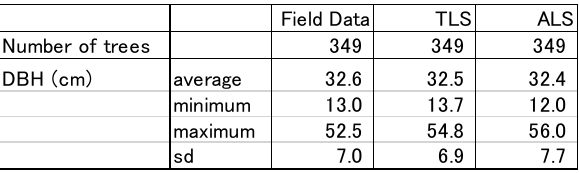
Table 2. Comparison of stand-level diameter at breast height (DBH) measurements collected in the field, and by TLS and ALS